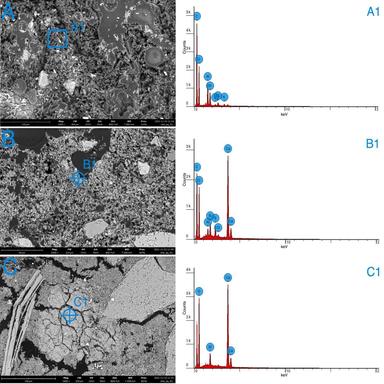
Results of SEM-EDS analysis on sample Uhe_aq_03. BSE image indicating the area/point where the elemental analysis shown next was carried out. A. Binder of the sample at a gypsum lump. A1. Elemental chemical analysis of the binder revealing enrichment of S. B. Binder of the sample. B1. Elemental chemical analysis of binder confirming Ca-based binder with S content, and small amount of Al, Si. C. Lime lumps with a network of micro-cracks. C1. Elemental chemical analysis of the lime lump, confirming the prese